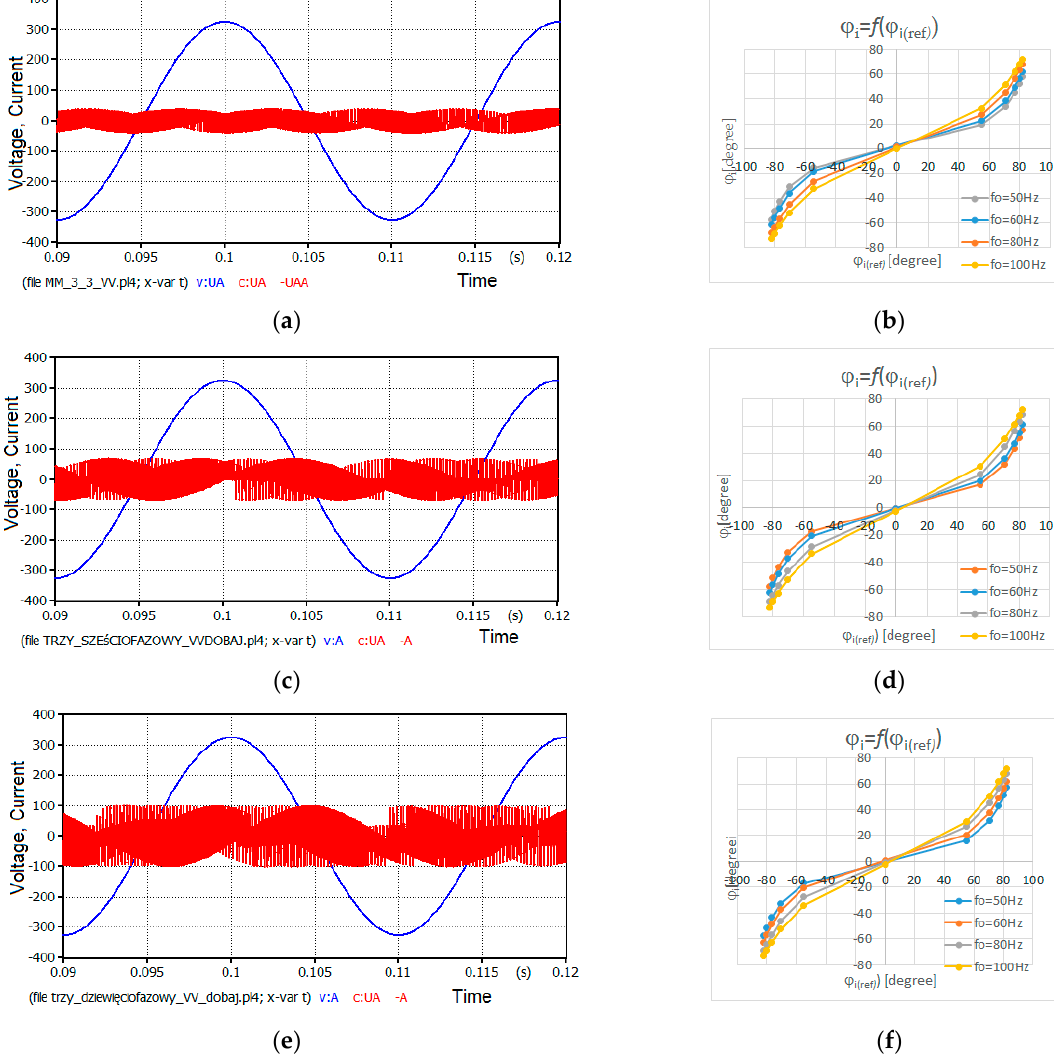
Figure 9. Input phase voltage (blue) and input current (red) for: three-to-three-phase MC ( a ); three-to-six-phase MC ( c ) and three-to-nine-phase MC ( e ). Input displacement angle versus referenced input displacement angle for: three-to-three-phase MC ( b ); three-to-six-phase MC ( d ); three-to-nine-phase MC ( f ).